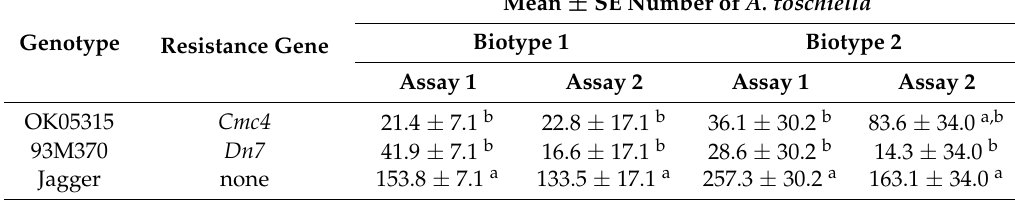
Table 4. Mean ± SE number of A. tosichella biotype 1 and 2 on wheat genotypes with genes for resistance to A. toschiella ( Cmc4 ) or D. noxia ( Dn7 ), and the susceptible control Jagger at 14 d post-infestation in a no-choice